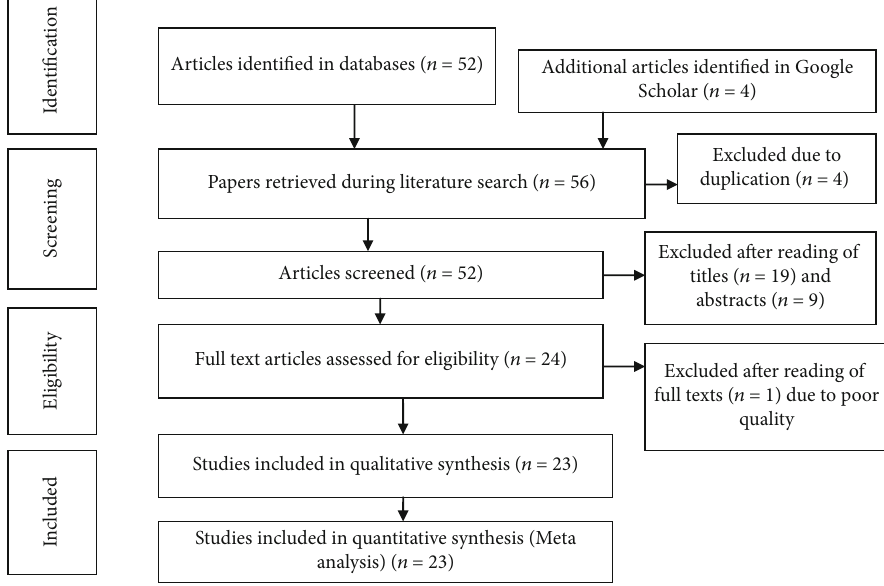
Figure 1: Flowchart showing the selection process of primary Table 1: Summary of primary studies of reporting treatment outcome among all age group epileptic patients in Ethiopia ( n = 23 ).